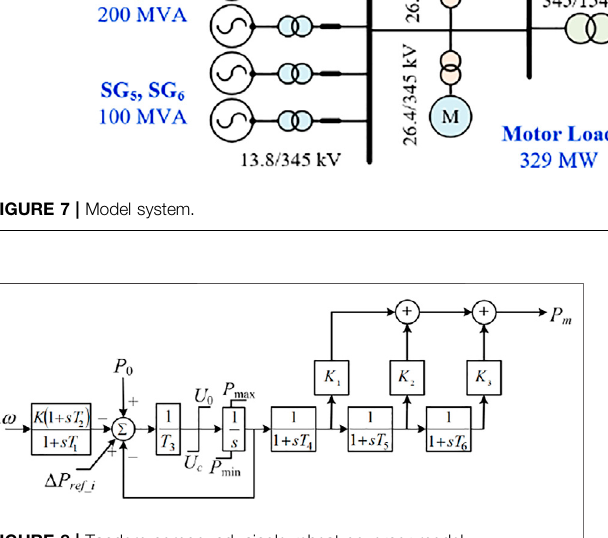
FIGURE 8 | Tandem-compound, single-reheat governor model.